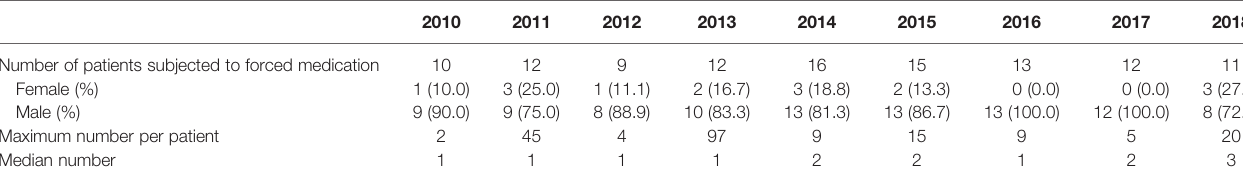
TABLE 4 | Forced medication in years 2010 to 2018.